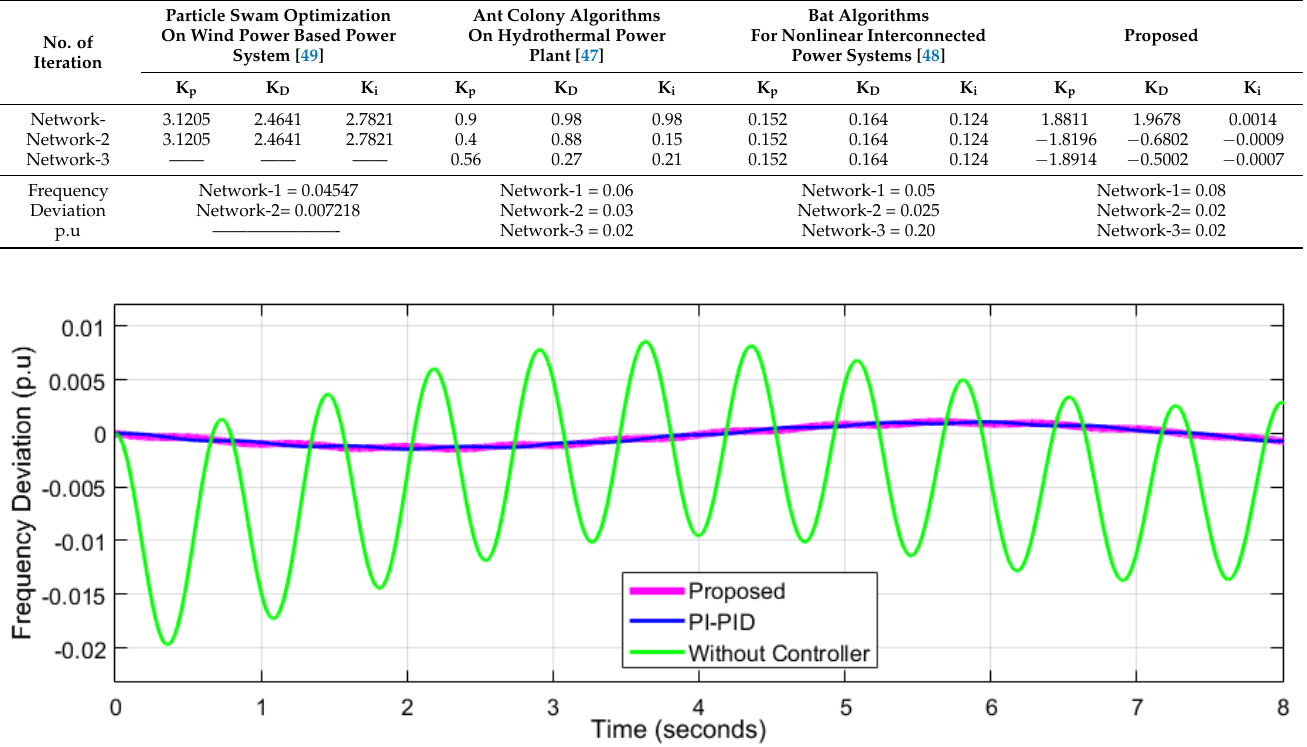
Figure 4. Case 1: frequency deviation at (K p = −1.6066, K i = −0.0024) for network 1.